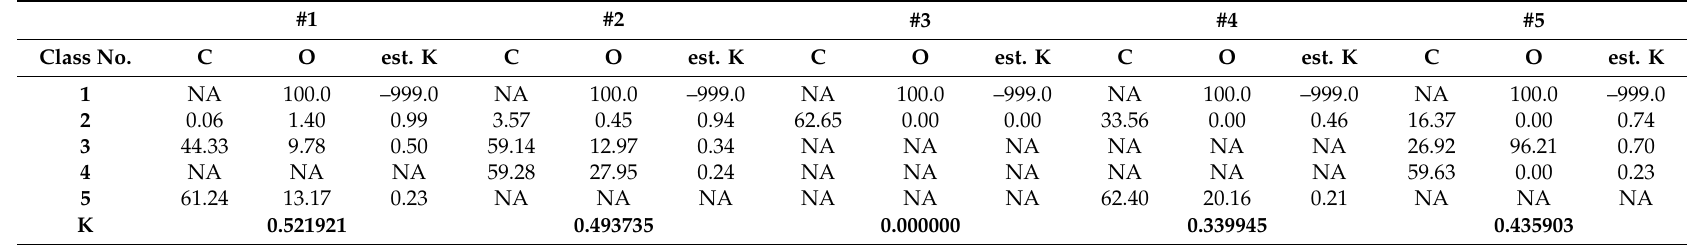
Table 6. The accuracy assessment of the Artificial Neural Network for the Varaždin study area.